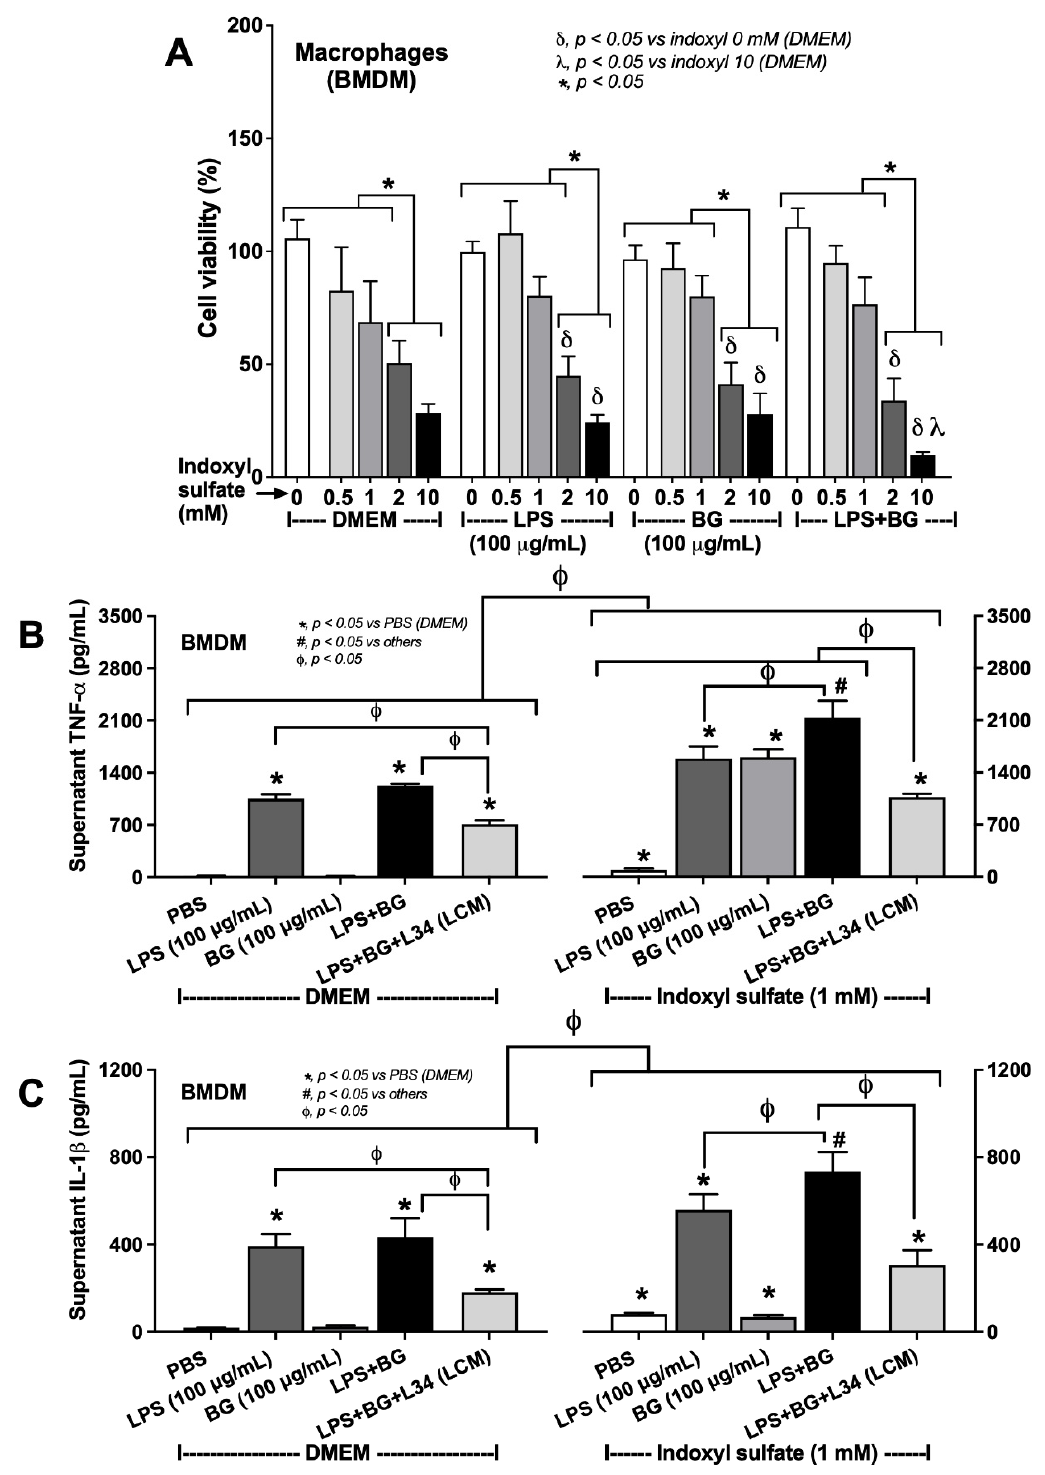
Figure 6. ( A ) The cell viability (MTT assay) of bone marrow-derived macrophages (BMDM) after incubation by the different concentrations of indoxyl sulfate together with culture media control (using DMEM) or lipopolysaccharide (LPS) at 100 µ g/mL with or without (1 → 3)- β -D-glucan (BG) at 100 μ g/mL are demonstrated. The supernatant cytokines: ( B ) TNF- α ; and ( C ) IL-1 β in stimulated BMDM with or without 1 mM indoxyl sulfate, a representative uremic toxin, is also demonstrated (independent triplicate experiments were performed for the in vitro experiments).